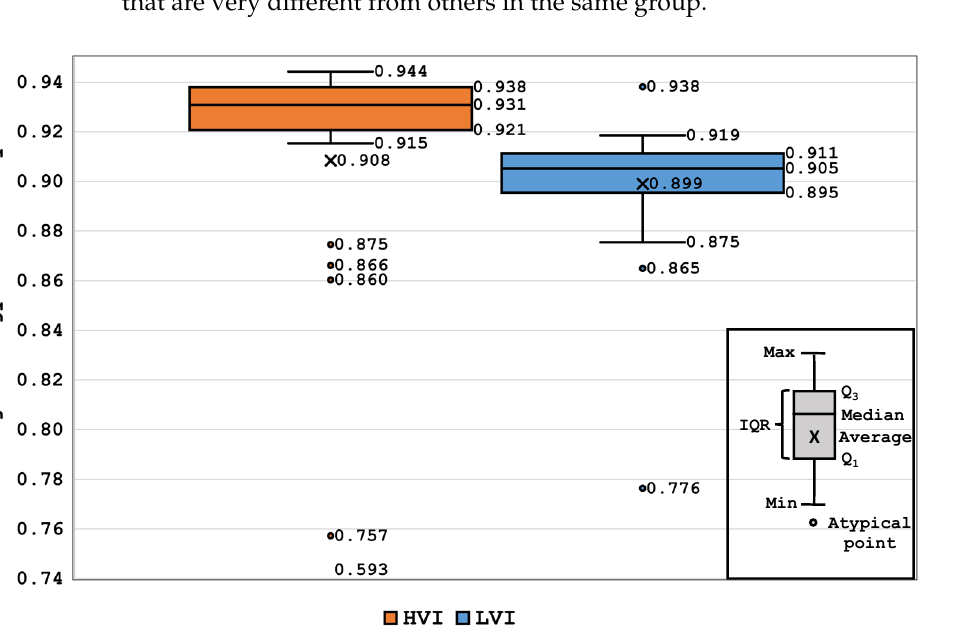
Figure 11. Distribution of